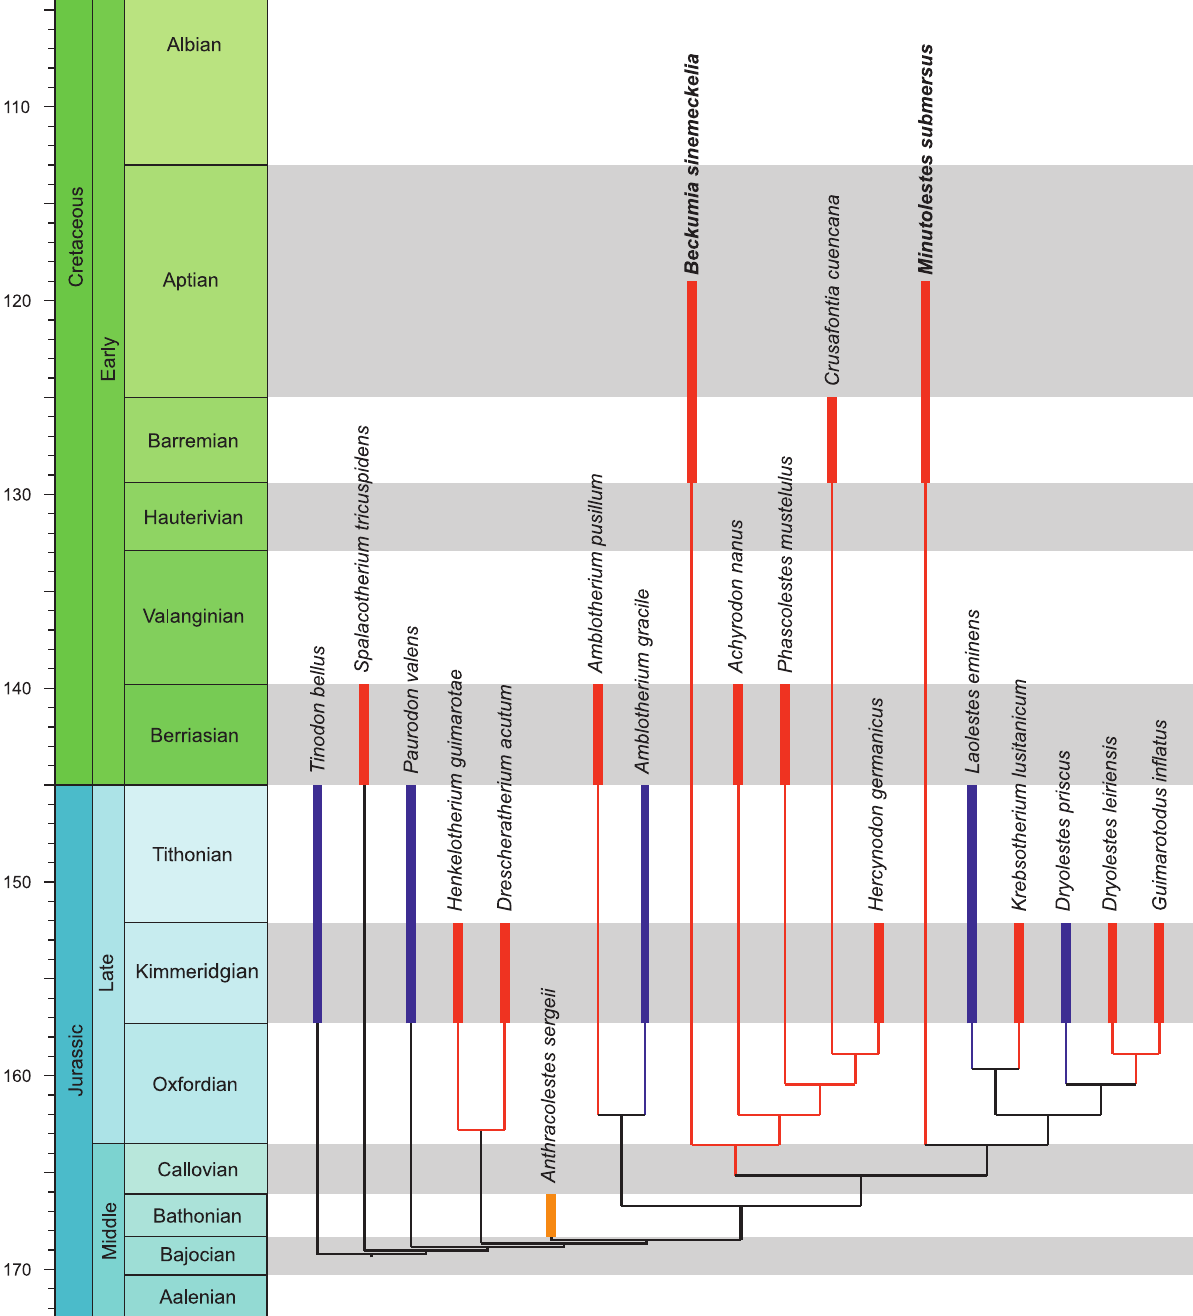
Fig. 13. Cladogram with interrelationships of the new dryolestids from the Barremian–Aptian (Early Cretaceous) of Balve. The nodes uniting taxa do not imply divergence times. Colors indicate distribution in the respective continents: red, Europe; blue, North America; yellow,